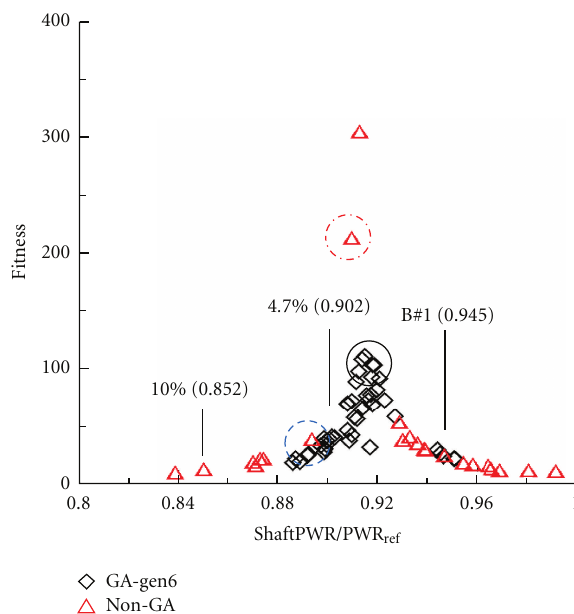
Figure 13: Fitness versus shaft power during design calculations.